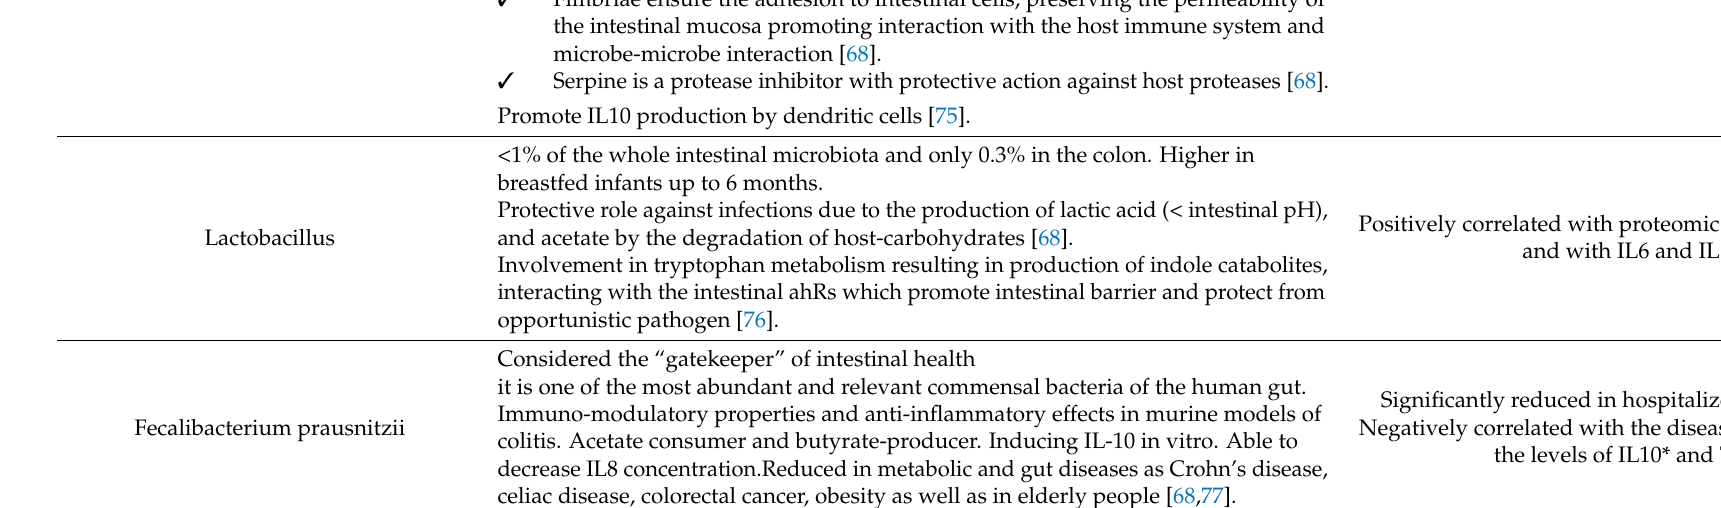
Bacterial Species Study Findings